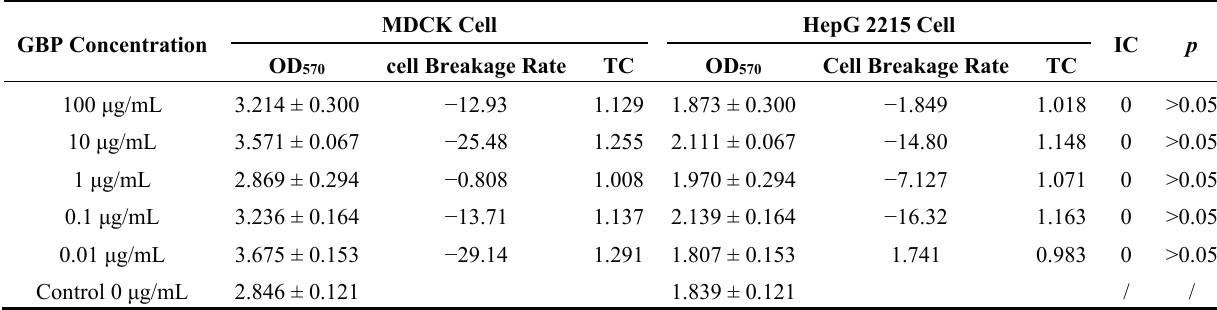
Figure 4. The particle diameter distribution of the GBP nanoemulsion under the optimum conditions. Table 1. Cell toxicity of GBP on MDCK and HepG 2215 cells ( χ ± s, n = 4). TC, toxic